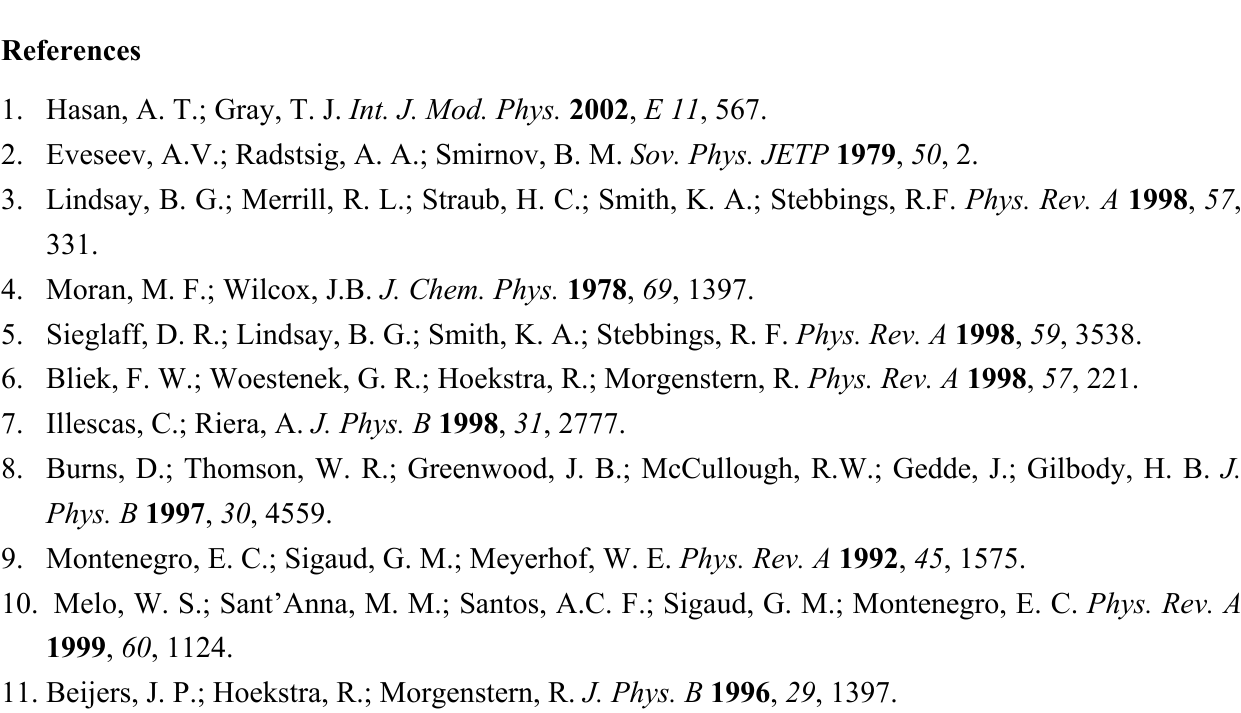
Figure 2. Dependence of the absolute total single-electron-capture cross section of + projectile